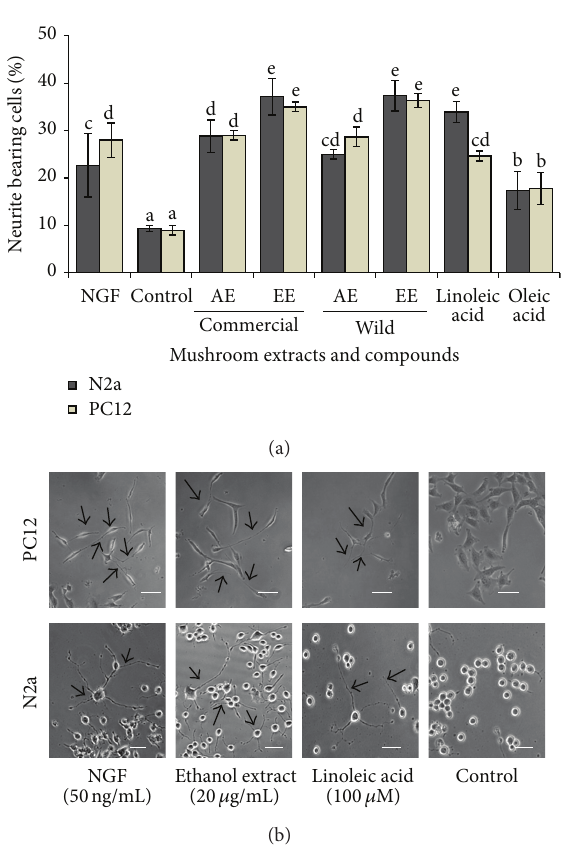
Figure 1: (a) Neurite-bearing cells (%) after 3-day incubation with NGF, mushroom extracts, linoleic acid, and oleic acid. AE: aqueous extract; EE: ethanol extract. Data are expressed as mean ± SD of three experiments. Different letters represent significant differences between samples ( 𝑃 < 0.05 ). (b) Phase-contrast photomicrographs showing the effects of NGF, ethanol extract, and linoleic acid on the morphology of PC12 and differentiating N2a cells after 3 days. Untreated cells serve as control and only contained 5% FBS as vehicle.Arrowsindicateneuriteextensionandscalebarcorresponds to 20 𝜇 m.